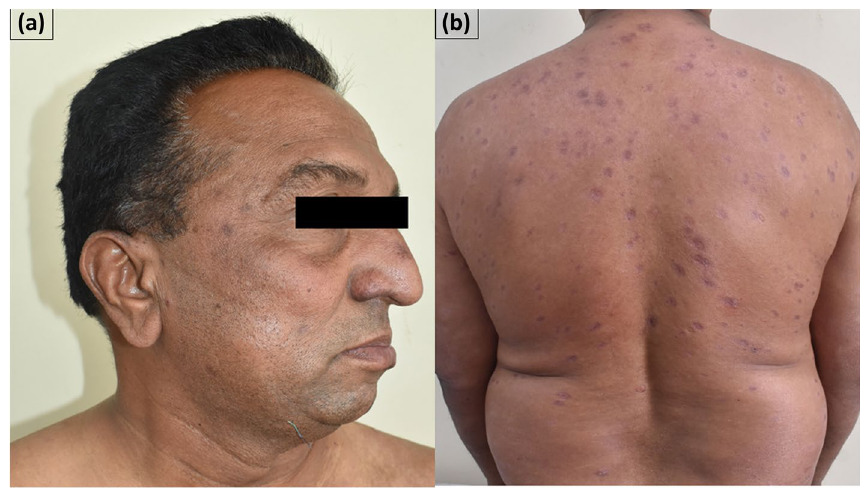
Fig. 3 a , b Complete resolution of cutaneous lesions with post-inflammatory hyperpigmentation after 4 weeks of prednisolone and methotrexate